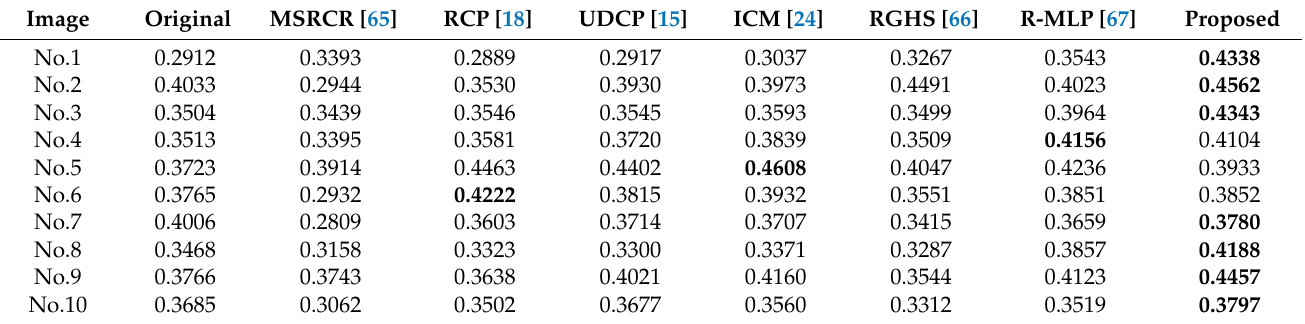
Table 4. Evaluation of images by UCIQE.